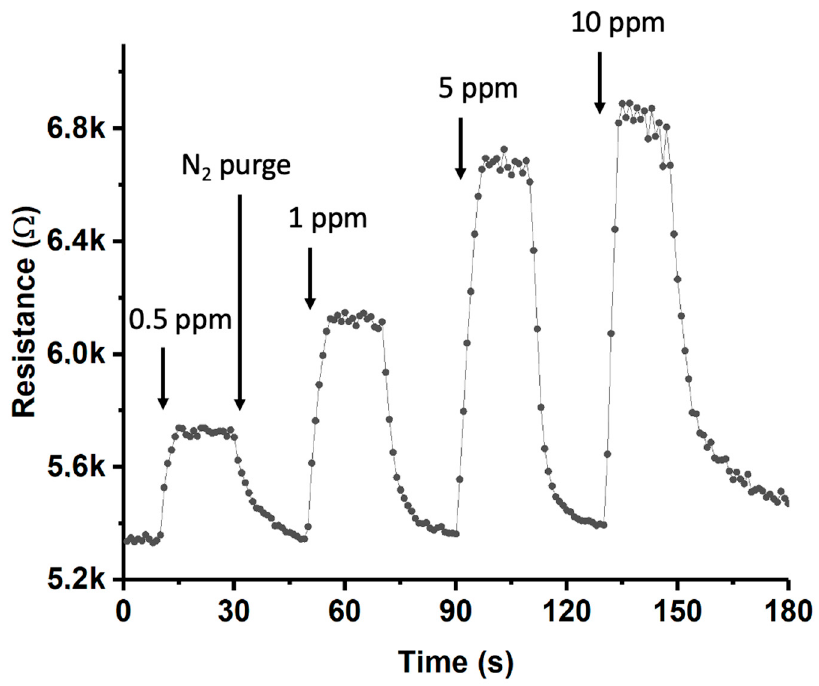
Figure 13. Dynamic response curves for the MoS 2 -Au(sputtering)-SWCNT composite gas sensor towards exposure to NH 3 (0.5, 1, 5, and 10 ppm) at 140 ◦ C. Table 1. Comparison of the results obtained in the present research with other ammonia